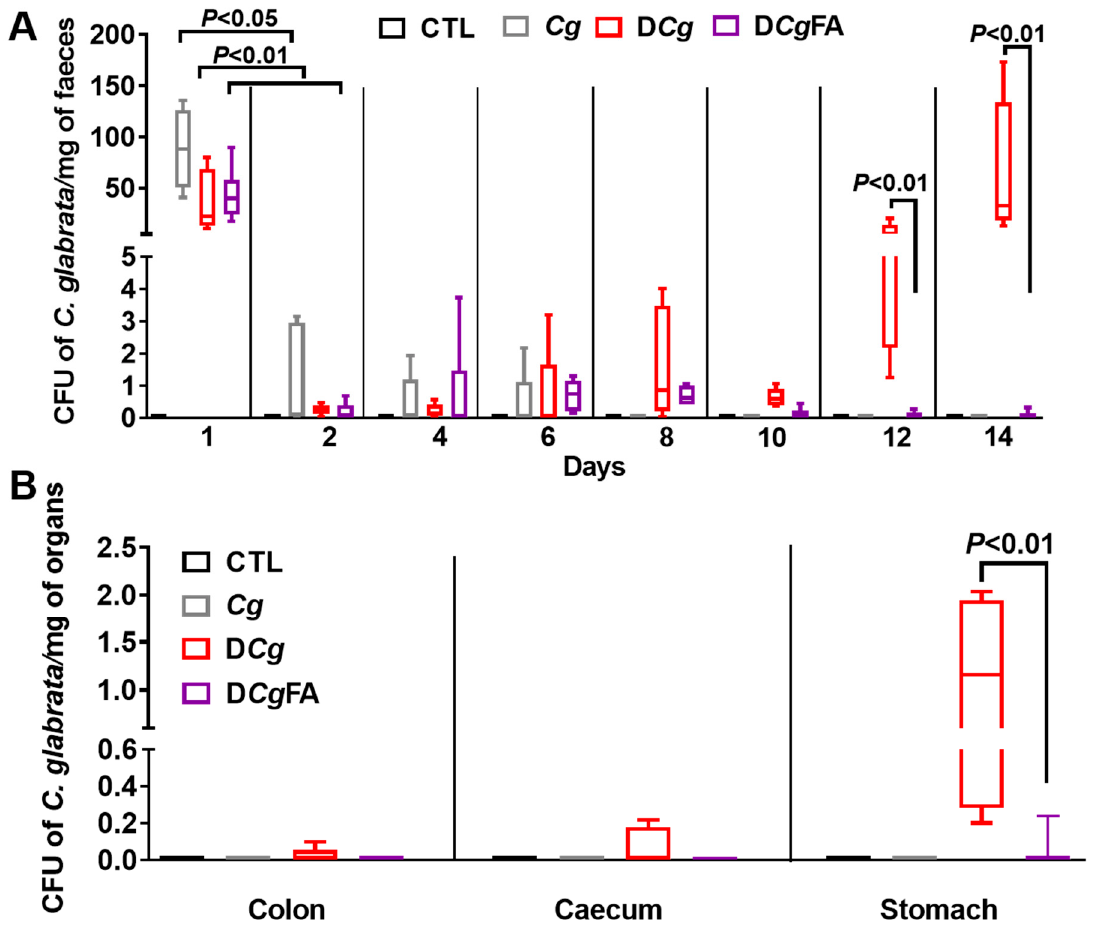
Figure 8. Effect of fatty acids (FAs) on C. glabrata elimination from the gut in mice with DSS-induced colitis. ( A ) Determination of the number of C. glabrata colonies recovered from stools. ( B ) Number of C. glabrata colonies recovered from the stomach, caecum, and colon. The four groups consisted of controls (CTL; water), C. glabrata alone ( Cg ), DSS + C. glabrata (D Cg ), and DSS + C. glabrata + FAs (D Cg FA). Data are the mean ± SD of six mice per group.